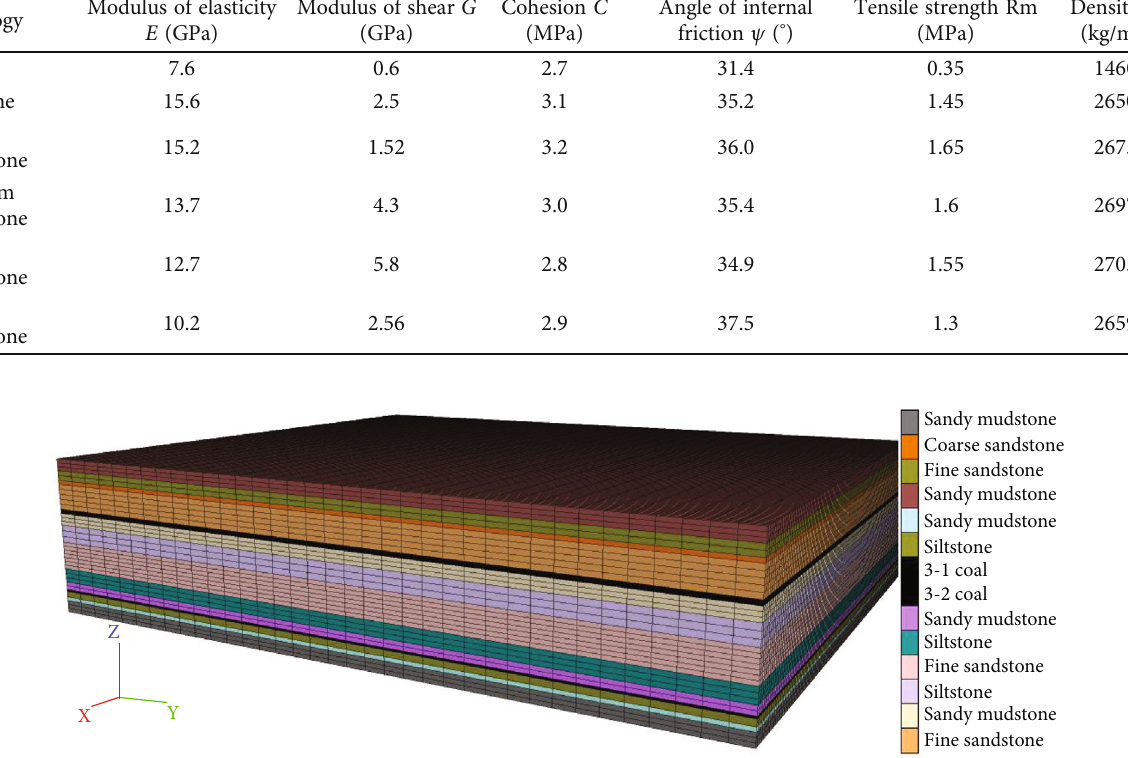
Figure 5: Three-dimensional numerical